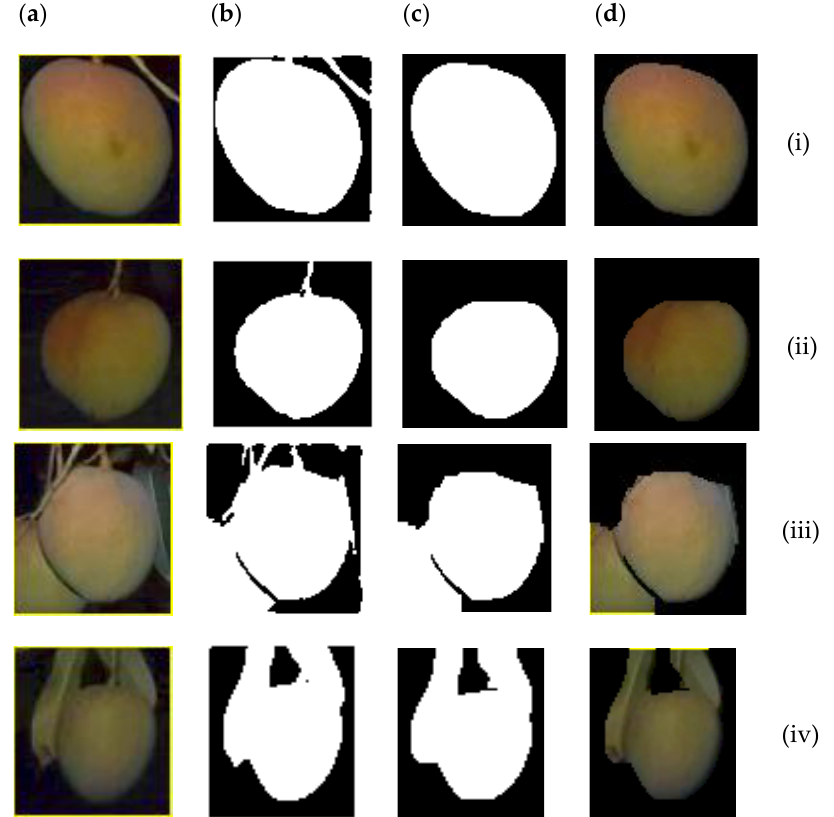
Figure 4. Segmentation using thresholding and morphological transformation: ( a ) image from YOLOv4-tiny bounding box, ( b ) thresholding using Otsu’s method, ( c ) stalk and noise removal using structuring element filtering with horizontal (2 × 10 pixels) and vertical (10 × 2 pixels) kernel filtering applied, ( d ) segmented portion of RGB image. Examples (i) and (ii) represent well segmented fruit, while (iii) and (iv) represent problems resulting from overlap with other fruit and leaves. Image (iii) is common to Figure 3.